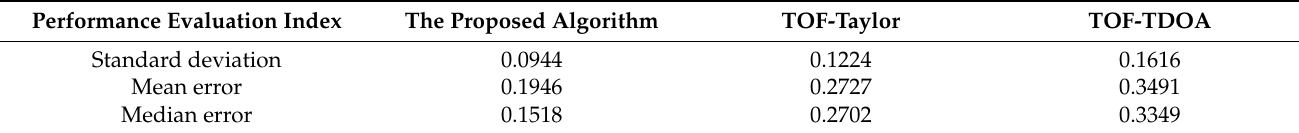
Table 1. Performance evaluation of the proposed positioning